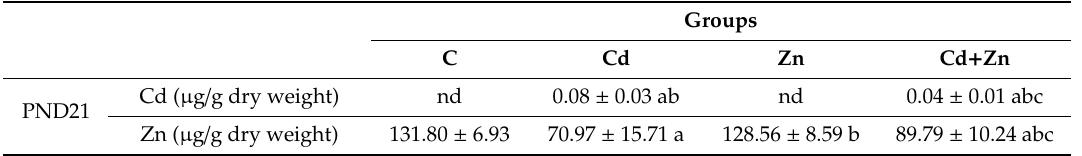
Table 1. Cadmium (Cd) and zinc (Zn) levels in femur male pups from mother’s rats treated with Cd and / or Zn during gestation and lactation